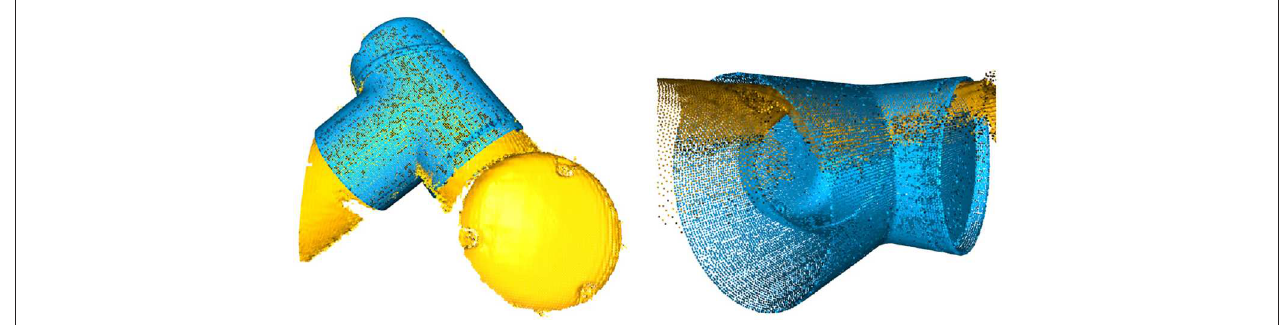
FIGURE 8 | The point cloud overlay between those captured by the 3D scanner (yellow) and those generated from the CAD model (blue) of the wrist link 1 on a UR5 e-series, and note the mismatch of the point clouds on edge.